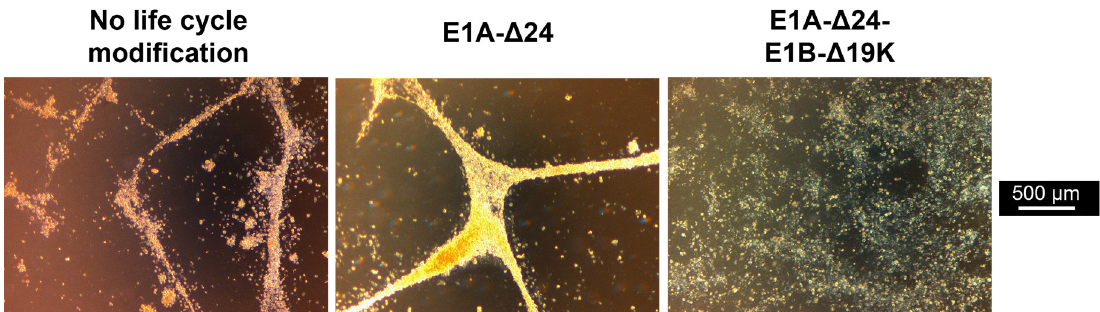
Figure 2. Infection of hMSCs with E1B- ∆ 19K-encoding virus results in a cytopathic effect with a different phenotype. BM-hMSCs were infected with pMOIs between 1 and 1000 using HAdV-5- HexPos3 particles harboring the indicated life cycle modification. Representative microscopic images of one hMSC donor, taken 72 h after infection with pMOI 1000, are shown.